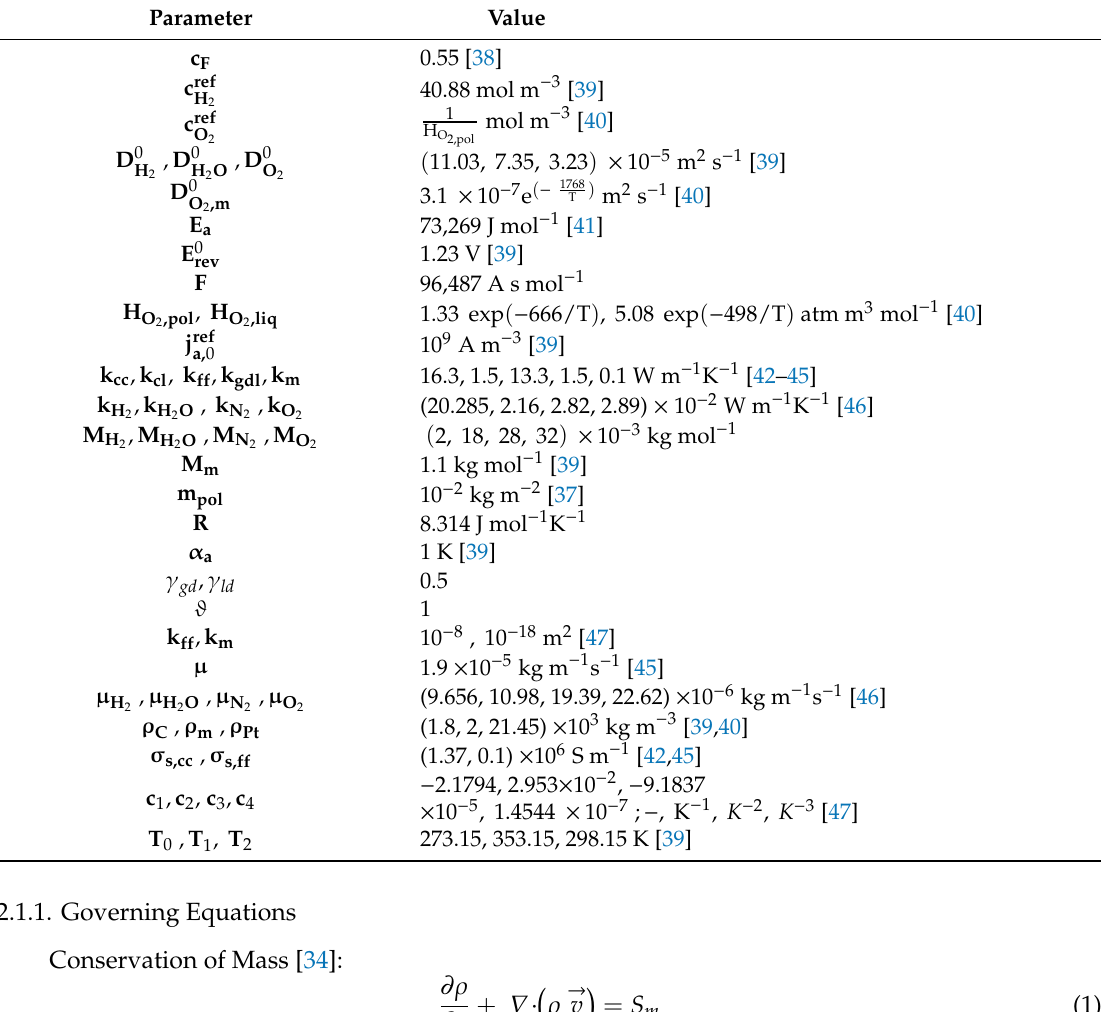
Table 2. Additional parameters for all